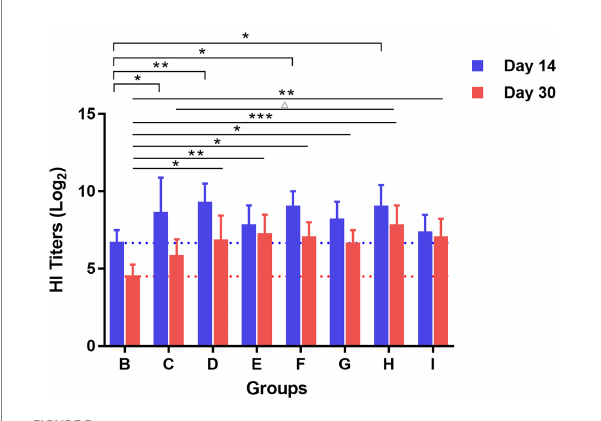
FIGURE 3 The response of HAI antibody titers to H1N1 virus measured by the hemagglutination inhibition assay on days 14 and 30 after booster vaccination. Each group was compared with the group given influenza vaccination alone (* p < 0.05, ** p < 0.01, *** p < 0.01), and influenza vaccine and Astragali Radix co-immunized group ( △ p < 0.05).